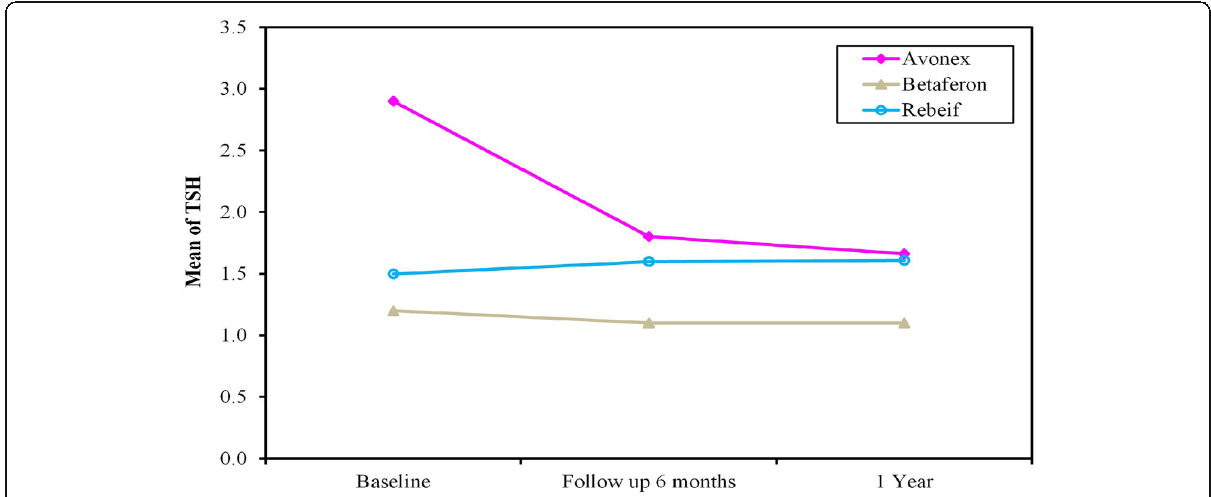
Fig. 3 Comparison between each separate drug groups at baseline, 6-, and 12-month follow-up periods according to